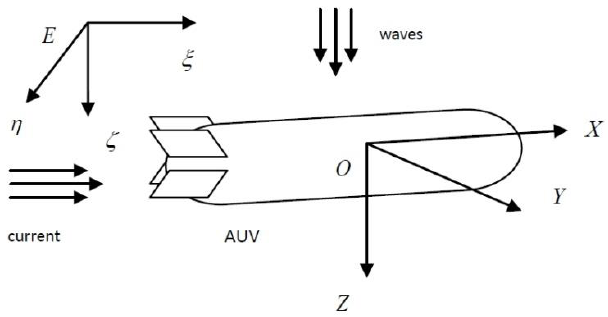
Figure 3. Coordinates and interference forces of the AUV.